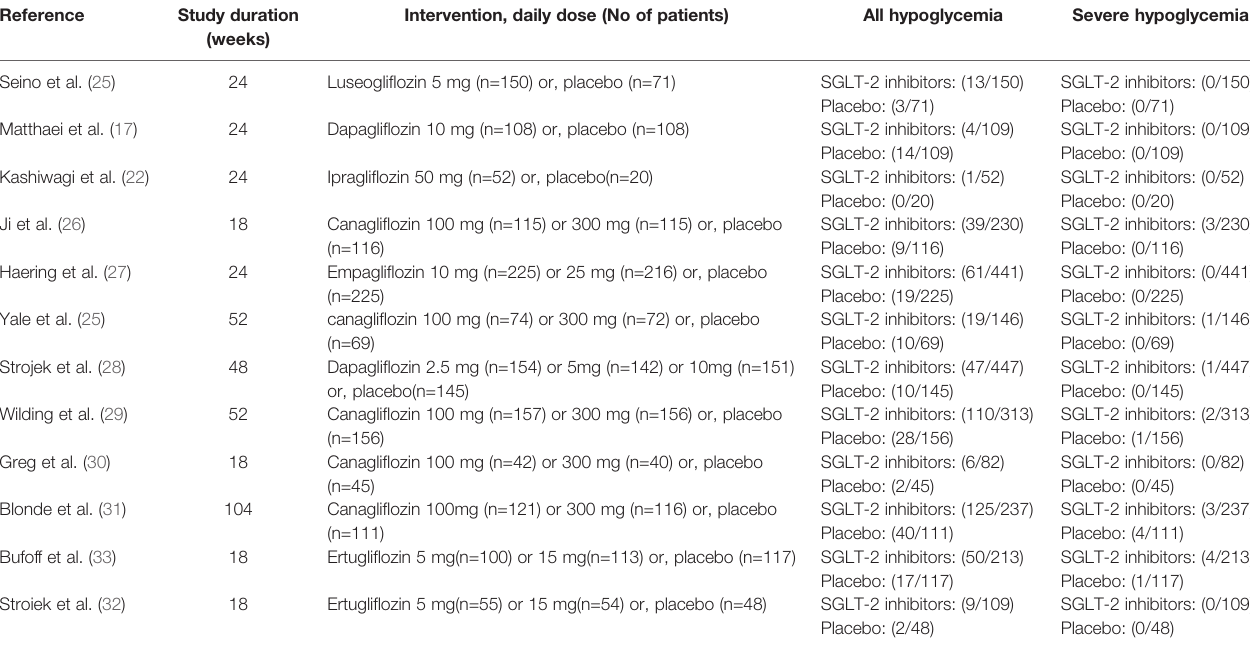
SGLT-2, Sodium-glucose Cotransporter-2.